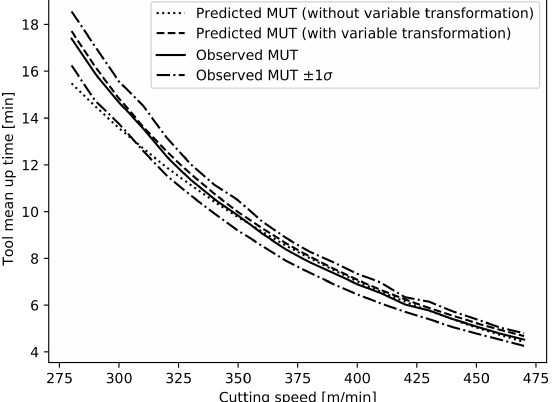
Figure 3. MUT estimate for cutting tools with and without logarithmic transformation.